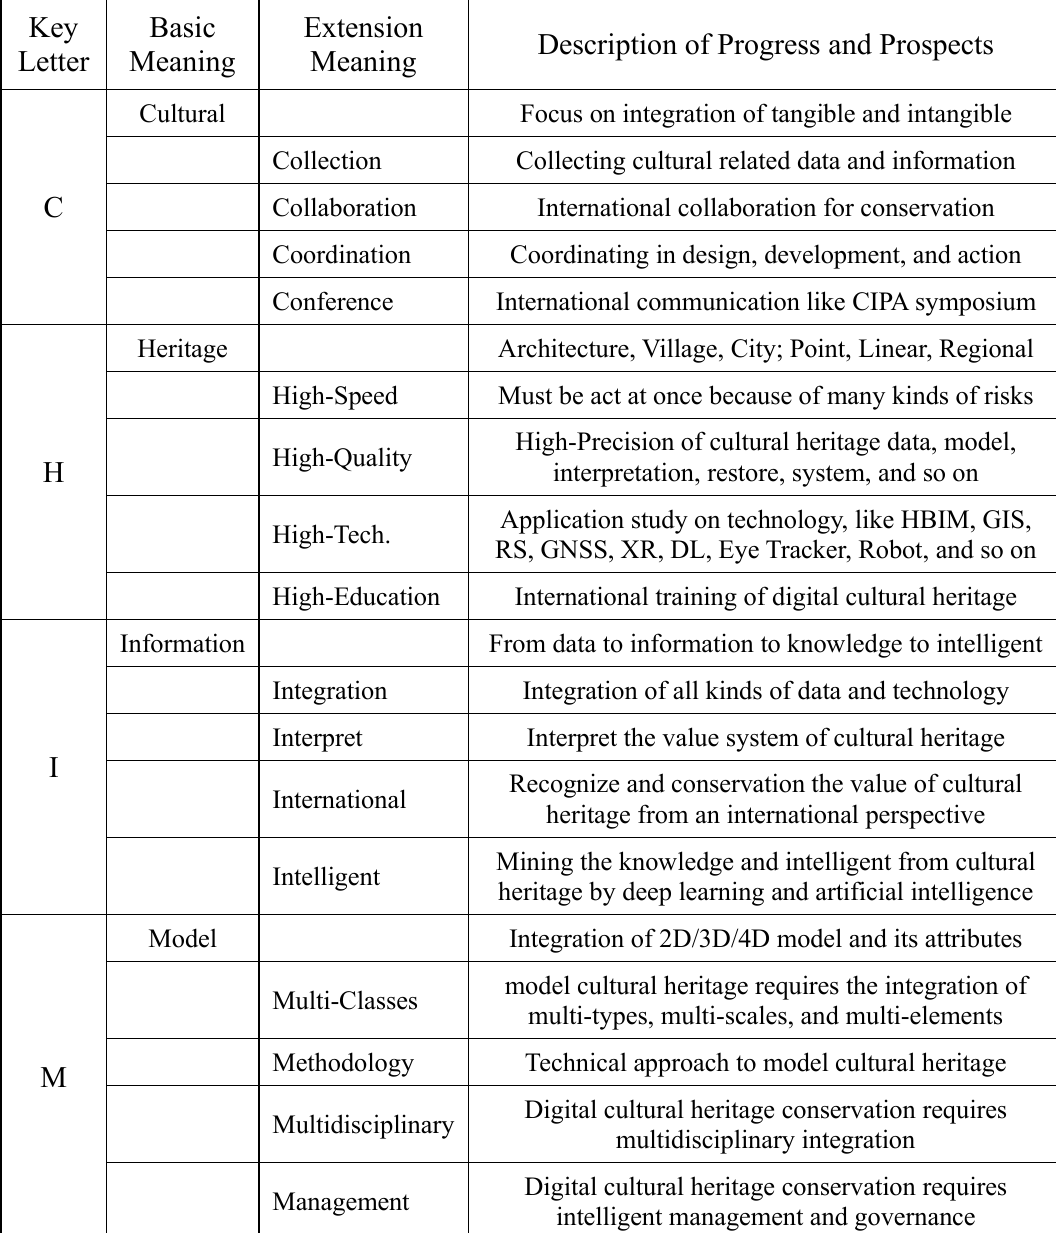
Table 1: CHIM —— Progress and Prospects of Digital Cultural Heritage Key Letter